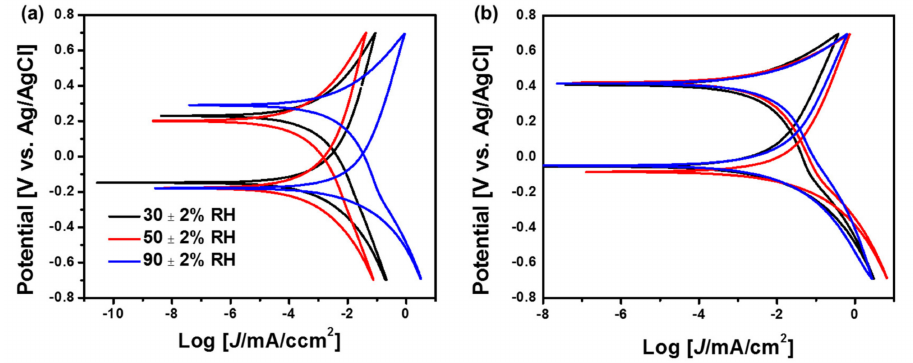
Figure 5. Tafel analysis derived from the voltametric profiles during forward and reverse scans of Nafion 117 ( a ) and PP80 ( b ) at di ff erent relative humidity